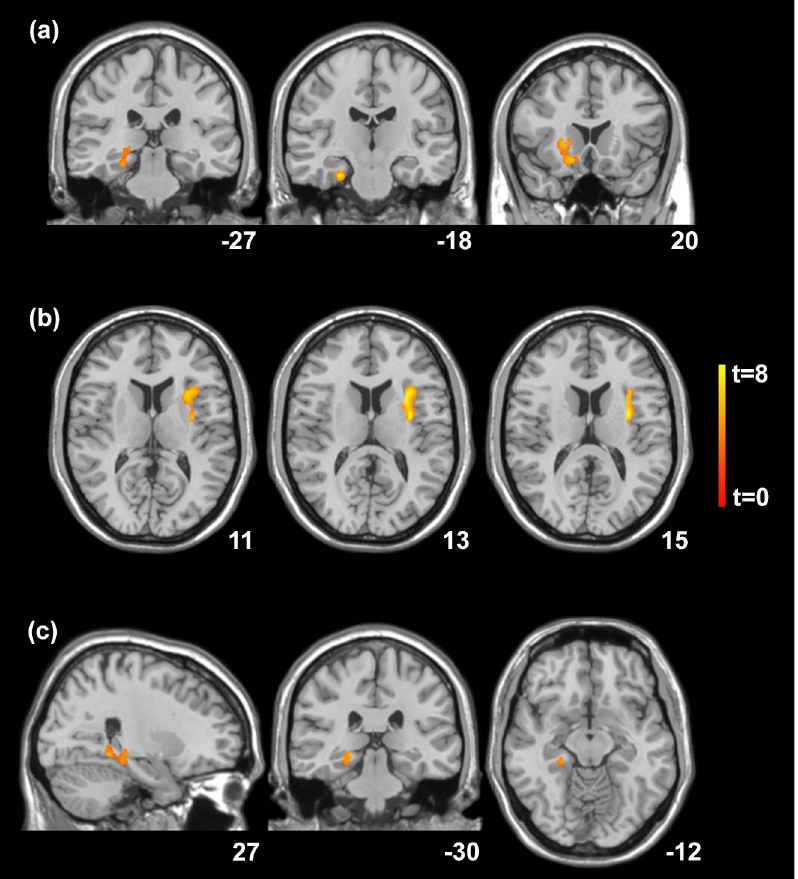
Fig 2. Statistical parametric mapping ( t ) intensity projection maps rendered onto a stereotactically normalized MRI scan, showing voxel cluster of increases of grey matter volume following second language training in ( a ) people with multiple sclerosis in MNI space (y = -27; -18 and 20; statistical significance thresholded at p < .001) and in (b) healthy control subjects in MNI space (z = 11; 13 and 15); (c) is showing areas of significant positive correlations of grey matter volume increase and vocabulary knowledge following second language training in a cohort of people with multiple sclerosis rendered on to a stereotactically normalized MRI scan in MNI space (x = 27; y = -30; z = -12).